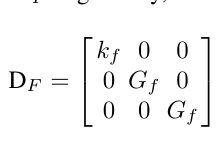
Fig. 5. Comparison of natural frequencies for Winkler and Pasternak’s type of elastic foundation ( K 1 = 500 ,h/a = 0 . 01 and number of nodes 19 × 19). where D F is given